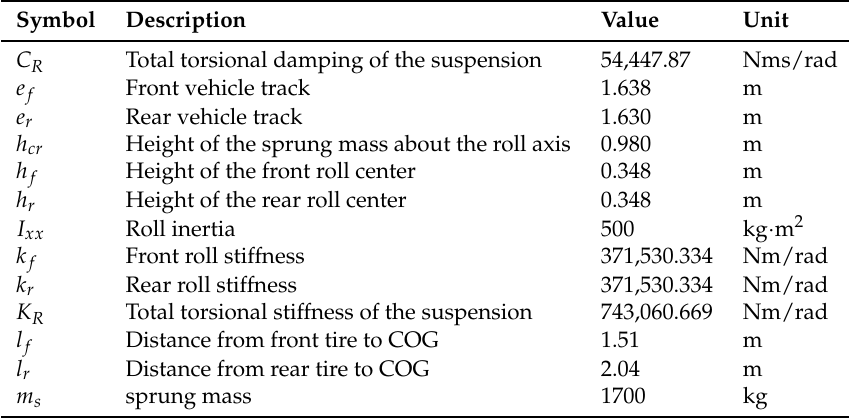
Table 3. State-space vehicle model parameters, COG, Center Of Gravity.